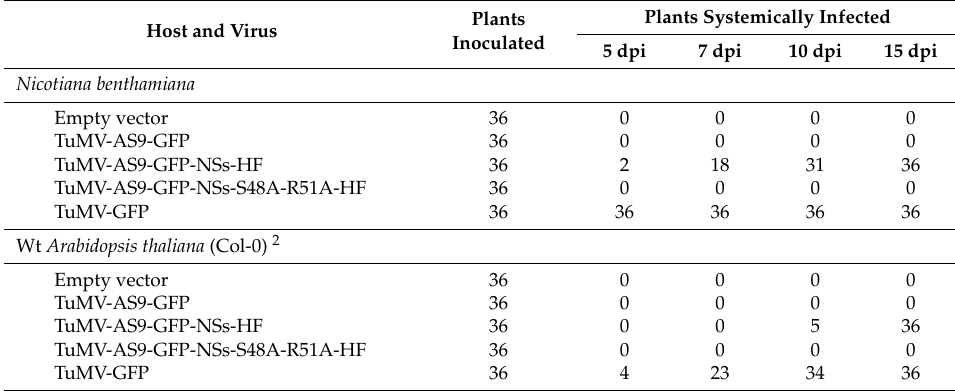
Table 1. Systemic infection of Nicotiana benthamiana and Arabidopsis thaliana by chimeric TuMV-AS9-GFP expressing active or suppressor-deficient NSs-HF 1